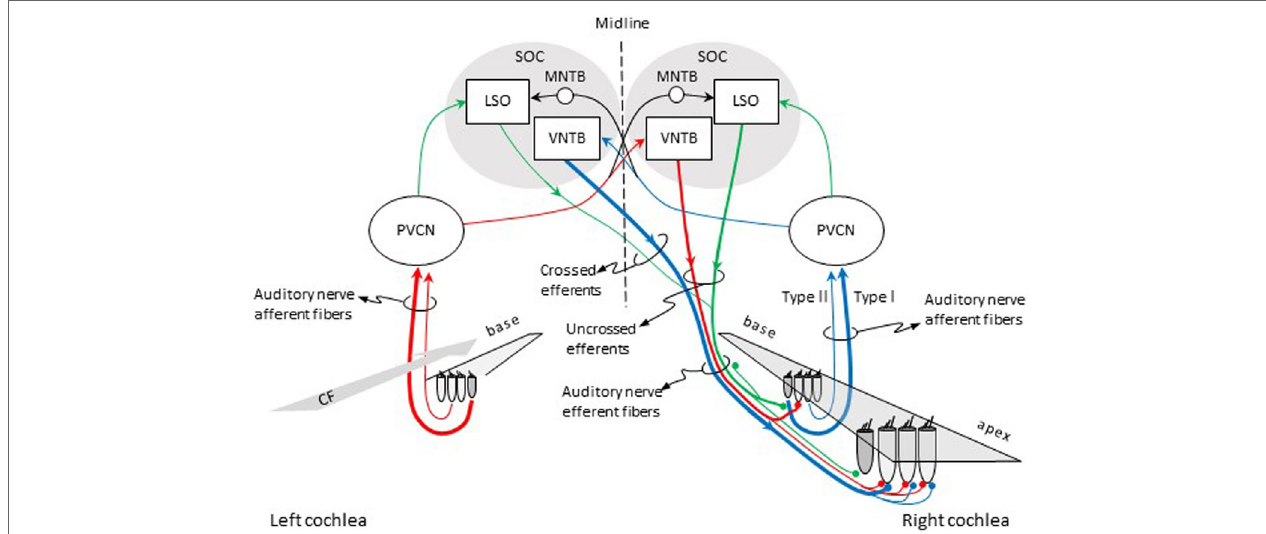
FiGURe 1 | Pathways for activation of medial (MOC) and lateral olivocochlear (LOC) efferent fibers to the right cochlea. Red and blue lines illustrate the pathways for activation of the contralateral and ipsilateral MOC reflexes, respectively. Green lines illustrate the pathways for activation of the LOC reflex. The thickness of each line roughly illustrates the density of innervation. Abbreviations: LSO, lateral superior olive; MNTB, medial nucleus of the trapezoid body; PVCN, postero-ventral cochlear nucleus; SOC, superior olivary complex; VNTB, ventral nucleus of the trapezoid body; CF, characteristic